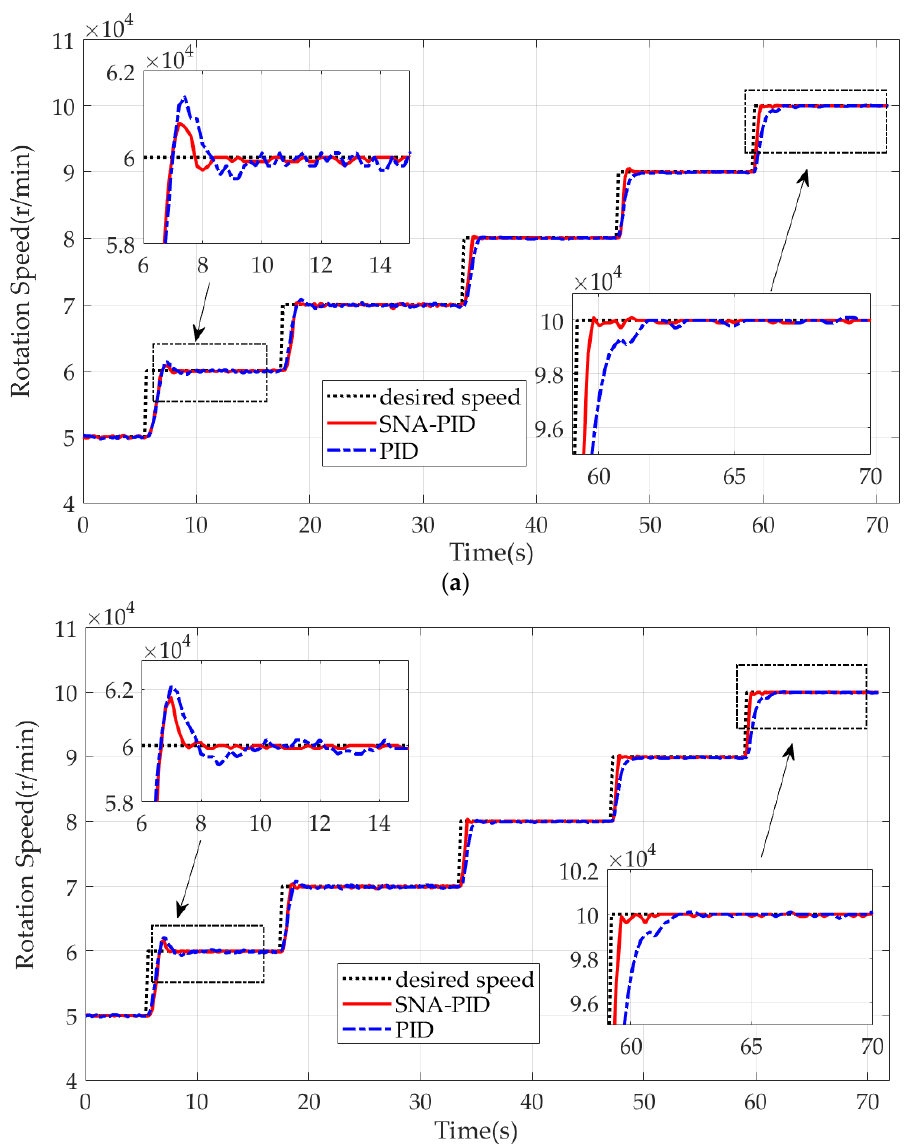
Figure 13. The rotor speed with SNA-PID control vs. conventional PID control. ( a ) Case I; ( b ) Case II. Table 5. Performance comparisons for Case I.